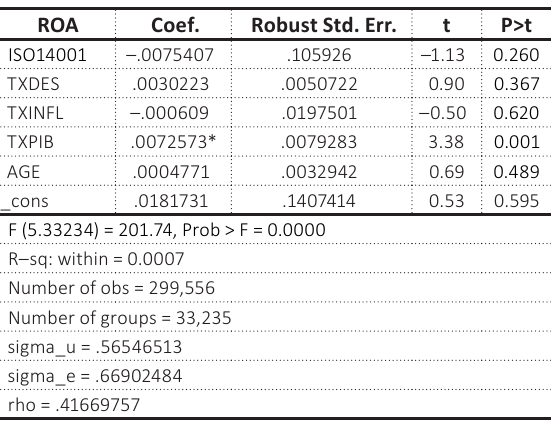
Table 6. Results of the ISO14001 regression model